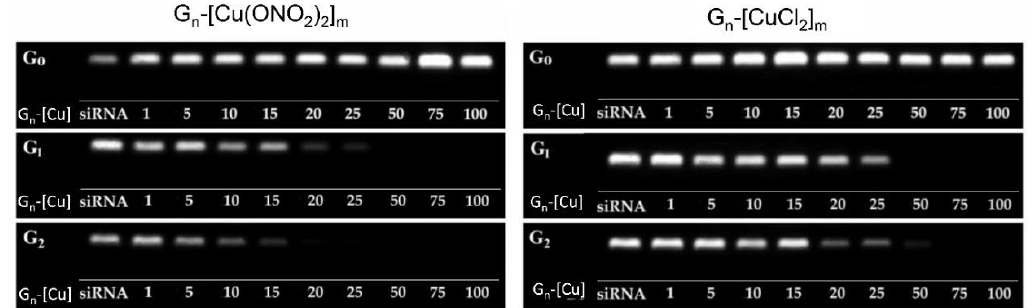
Figure 2. Formation of G n -[Cu]/siRNA complexes at different molar ratios. G n -[Cu]: dendrimer,